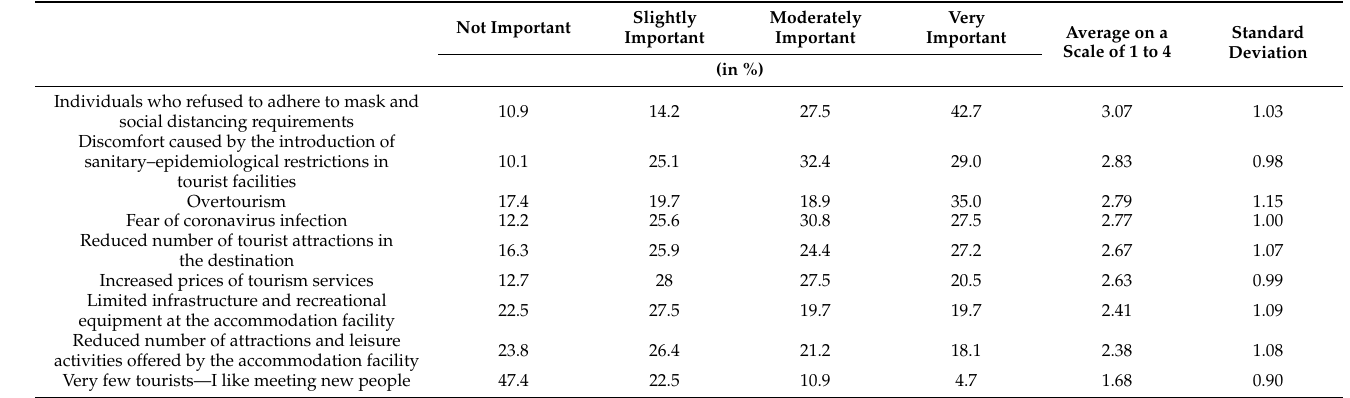
Table 6. Pandemic-related sources of discomfort among the respondents during their excursions in 2020 (in %, n =